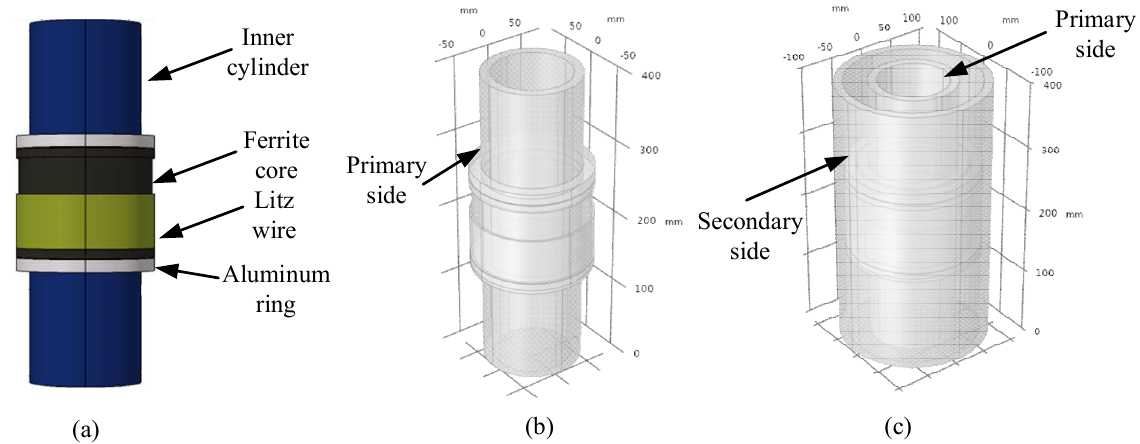
Figure 3. The proposed coupling mechanism: ( a ) The schematic diagram of primary side coupling mechanism; ( b ) the COMSOL model of primary side coupling mechanism; ( c ) the COMSOL model of the whole system.